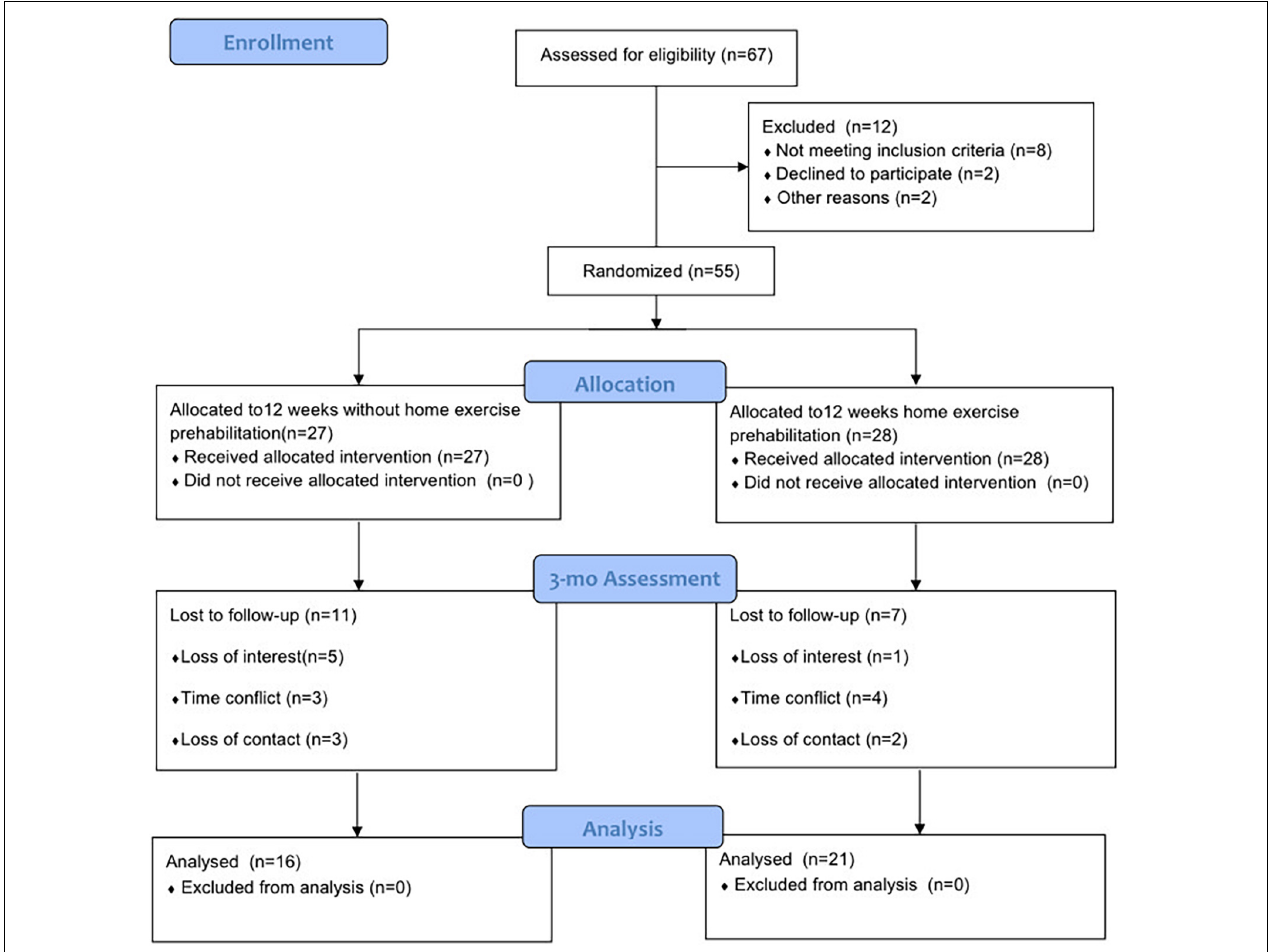
FIGURE 1 | Flow chart of the test. 6MWT: 6-min walk test, 5R-STS: 5 repetition-Sit-to-stand test, SF-36: Short Form Health Survey